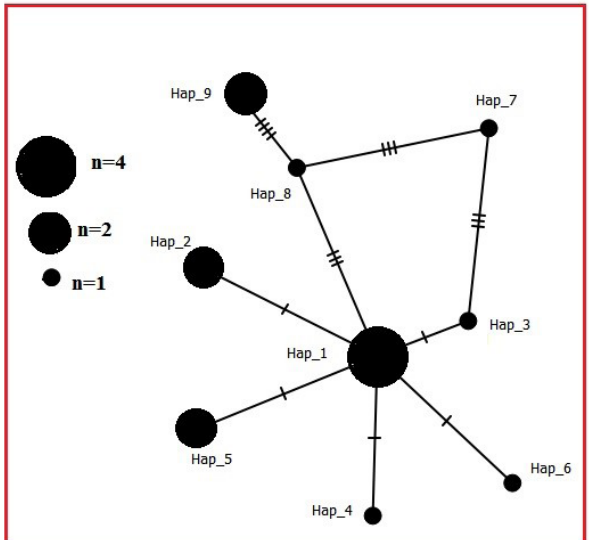
Figure 4. 95 % minimum spanning haplotype network of COI haplotypes of Clausidium persiaensis from the Persian Gulf, Qeshm Island. The size of the circle is proportional to the frequency of that